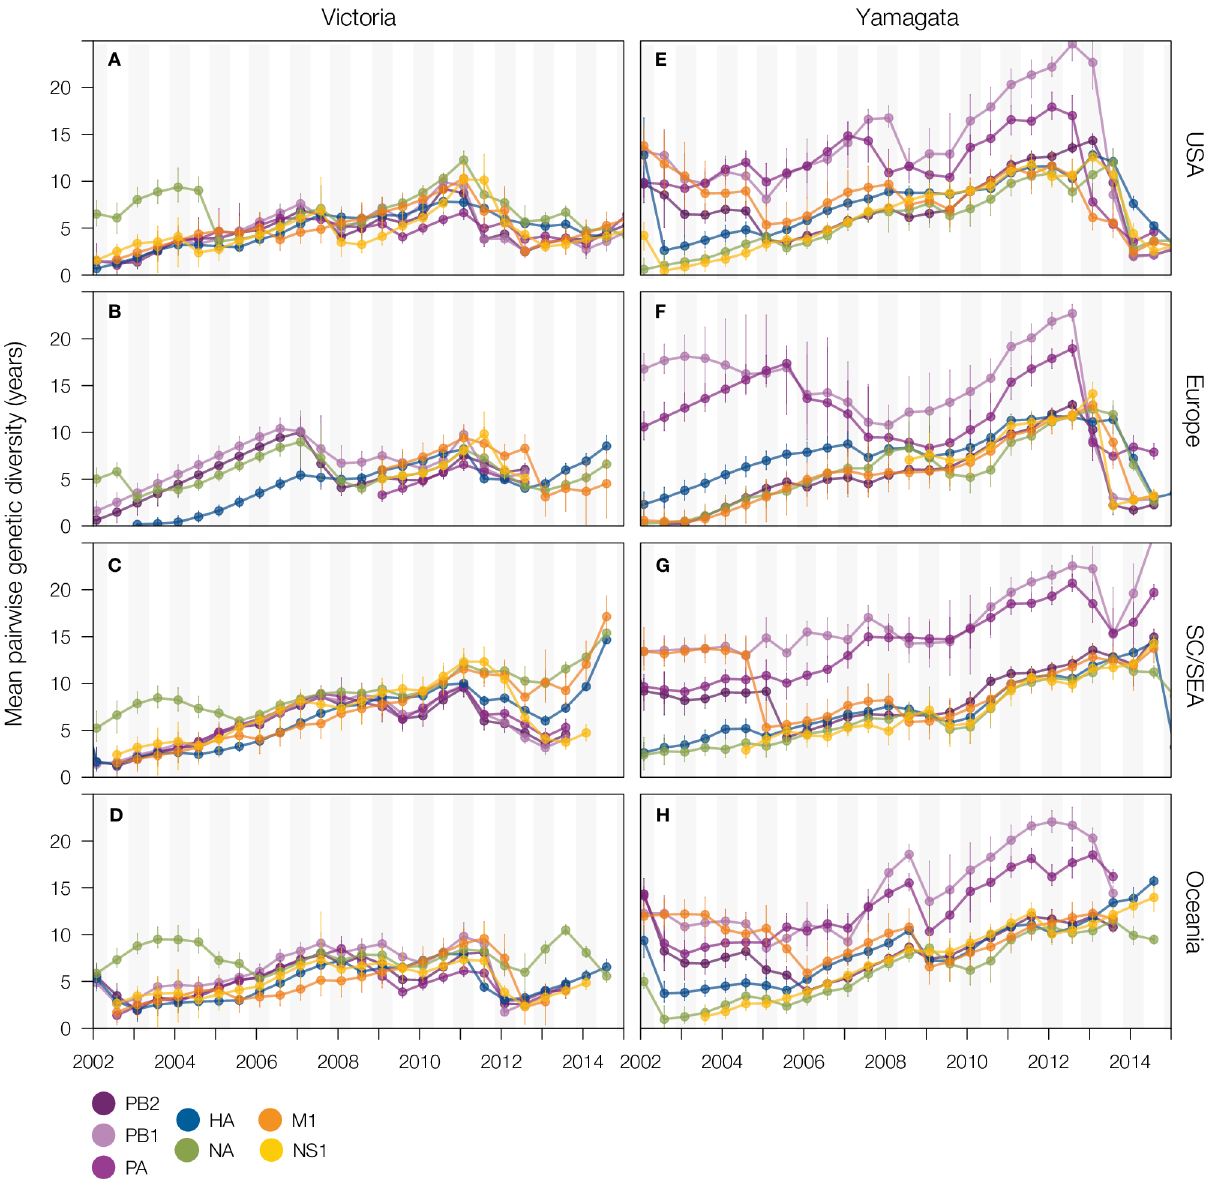
Fig 7. Genetic diversity of gene segments over time in different geographic regions. Time series of mean pairwise diversity (i.e. estimated average branch length distance between points in phylogeny at half- year intervals, measured in years) of Victoria- and Yamagata-lineage gene segments, for viruses collected from (A, E) USA, (B, F) Europe, (C, G) Southern China and Southeast Asia, and (D, H) Oceania.